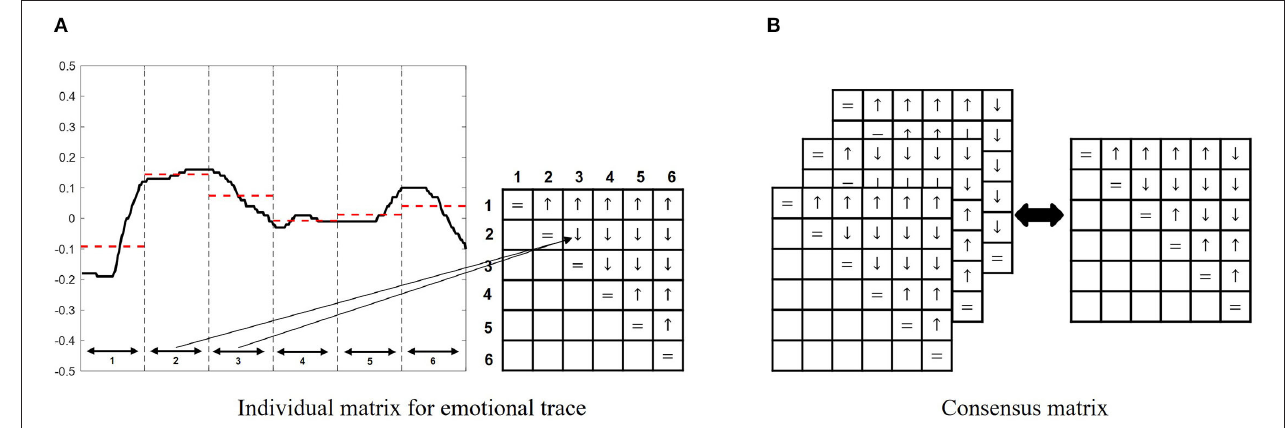
FIGURE 5 | Illustration of QA method (Parthasarathy and Busso, 2018). (A) Individual comparison matrix obtained from interval labels for one rater. Up-arrow indicates an increase; down-arrow indicates a decrease and equal denotes tie. (B) Consensus matrix obtained by aggregating individual matrix collected from multiple raters using majority